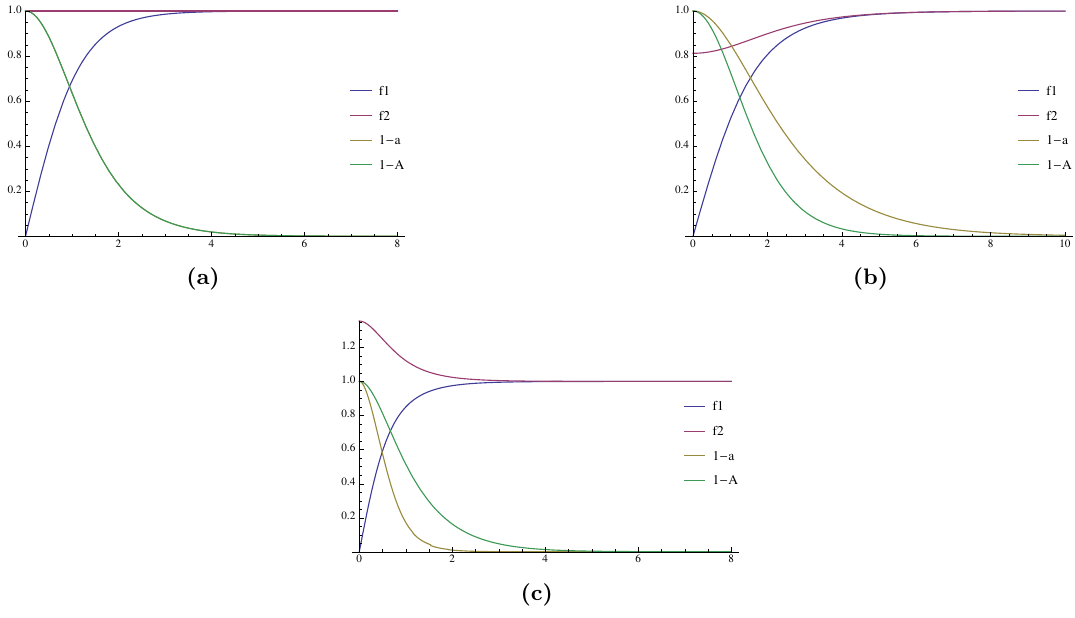
Figure 1. The pro(cid:12)le functions f (cid:0) a ( (cid:26) ) and 1 (cid:0) A ( (cid:26) ) as functions of the distance 1 ( (cid:26) ) , f 2 ( (cid:26) ), 1 (cid:26) from the vortex center for a single Alice string vortex. We plot them for di(cid:11)erent values of the ratio l = e between the U(1) and SO(3) gauge couplings. (a) l =1, (b) l = 1 , (c) l = g 2